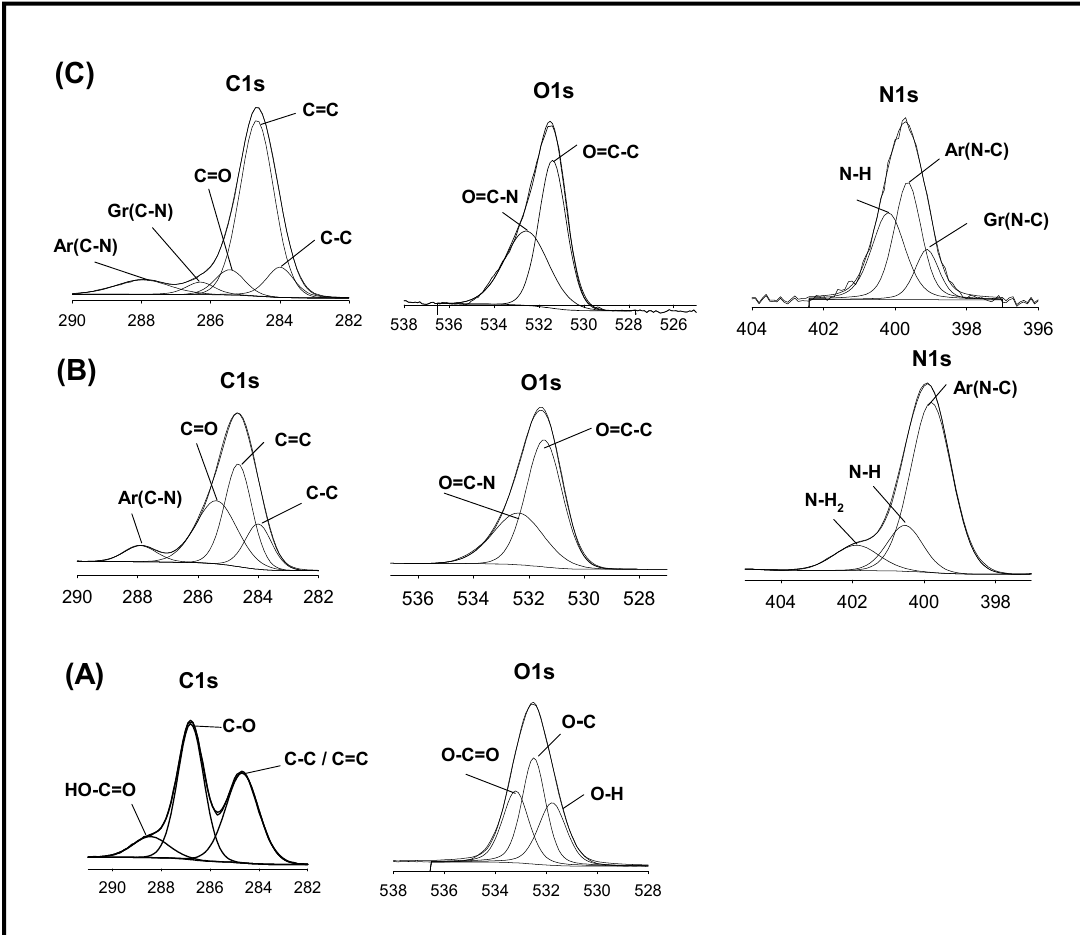
Figure 3. XPS spectra: GrO ( A ); Aramid pure ( B ); ArGrO Composite ( C ).